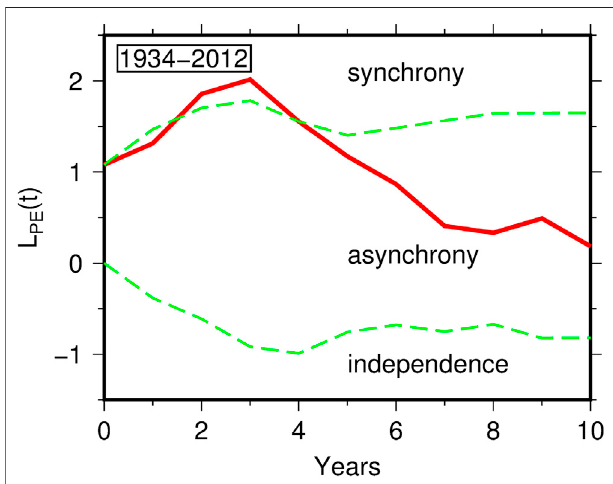
FIGURE 7 | Test for synchronization between M ≥ 4.8 earthquakes in northeastern Italy and peaks of sc-PDSI of Figure 5B restricted to the time period 1934 – 2012. The three curves indicate the function L PE (t) computed according to equation 2 (continuous line) and its 95% con fi dence envelope (dashed lines).